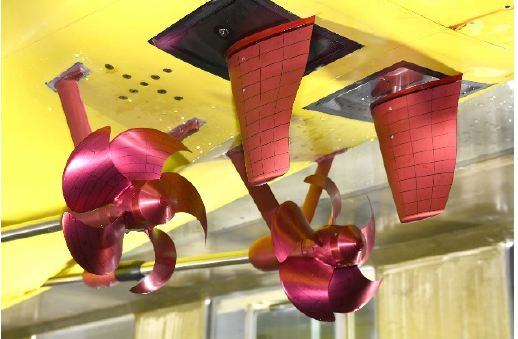
Figure 22. Photo of ship, propeller, and asymmetry-type rudder models.